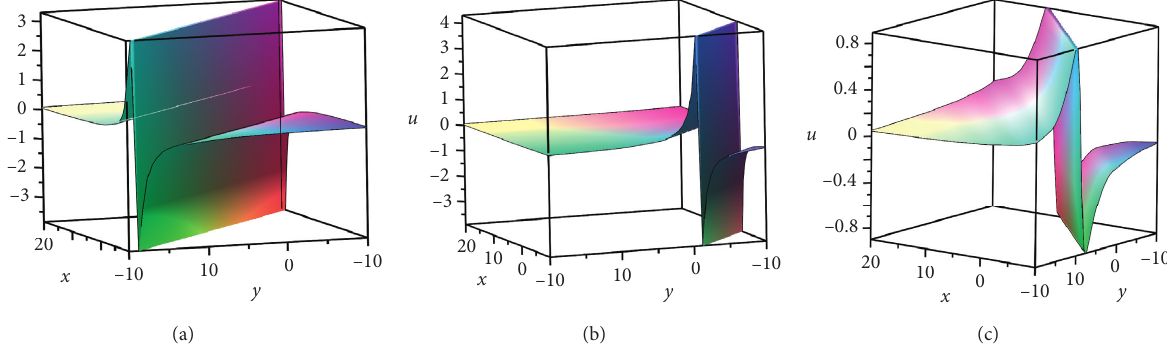
Figure 6: Spatiotemporal structure of solution (37) with parameter selections: a : t � − 10, a a